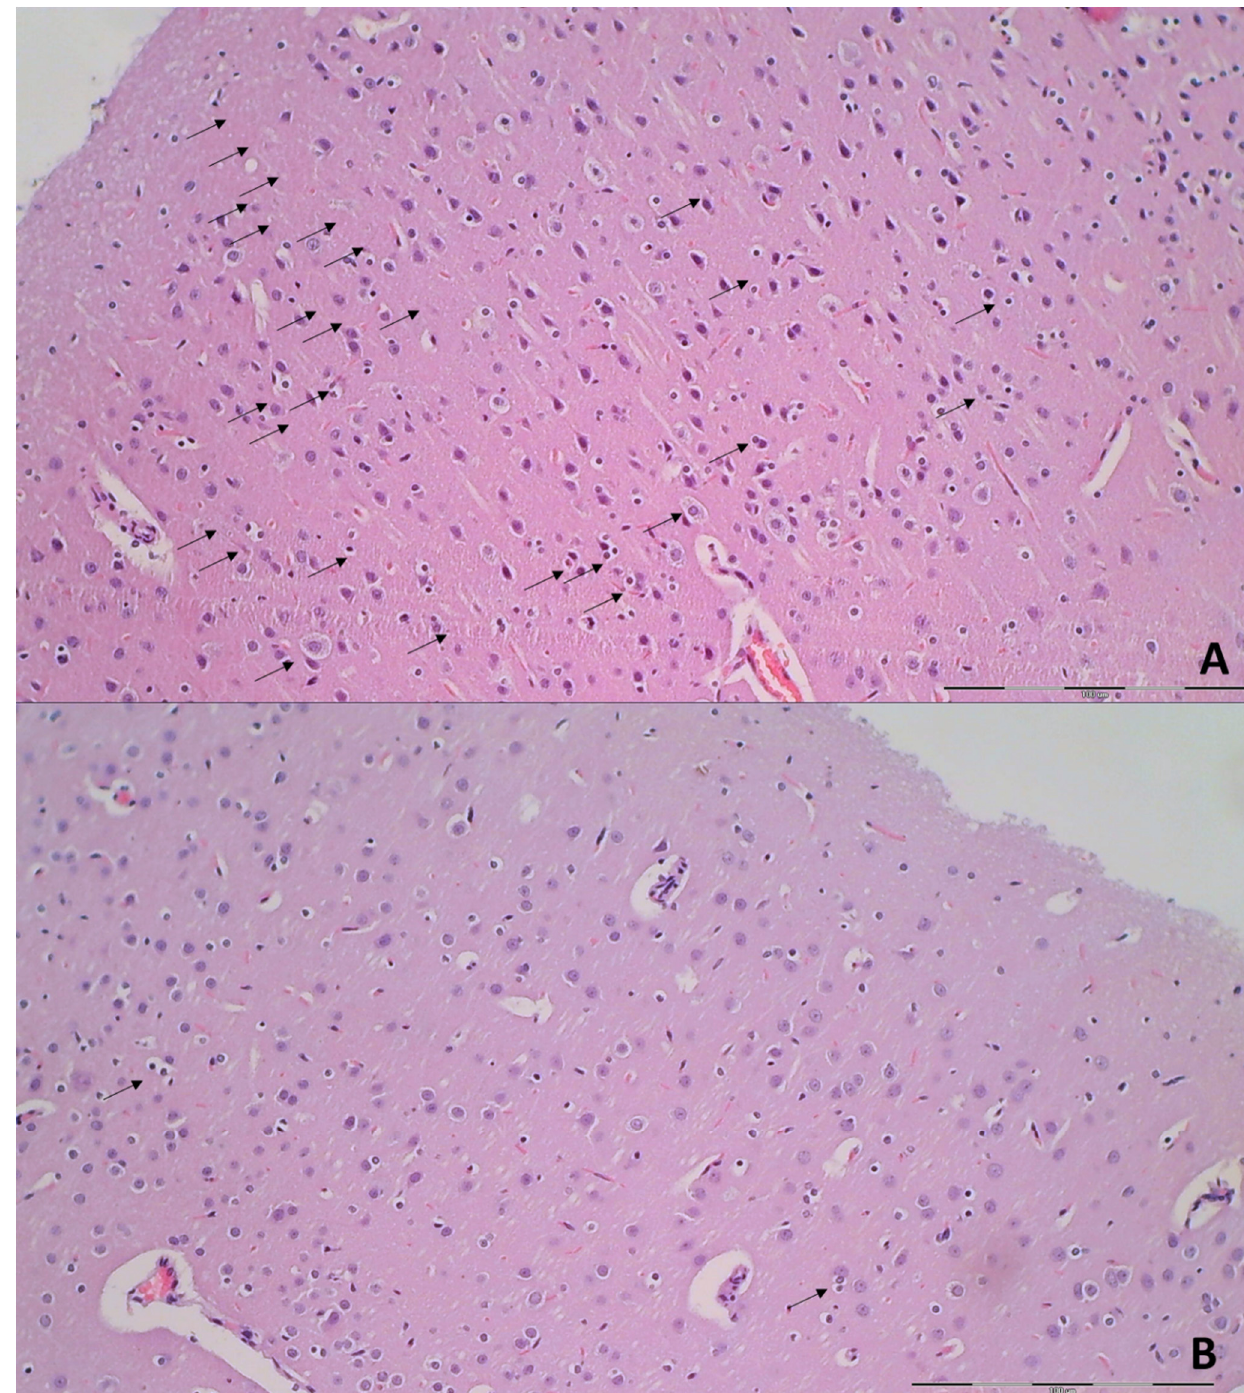
Figure 13. Microglia recruitment in cerebral cortex (HE staining). ( A ) Control groups after 24 h showed significantly more microglia cells with an amoeboid morphology in gray matter (arrows) (score 2). ( B ) BPC 157 after 24 h with less than 5 cells (arrows) (score 1). Magnification ×200 (( A , B ); scale bar 100 µm; Olympus BX51 objective 20×; field area 1 mm2). Furthermore, unlike BPC 157 rats, control rats exhibited significant lung, liver, kid- ney and heart lesions (Figures 10, 15 and 16). Specifically, there were the liver and lung